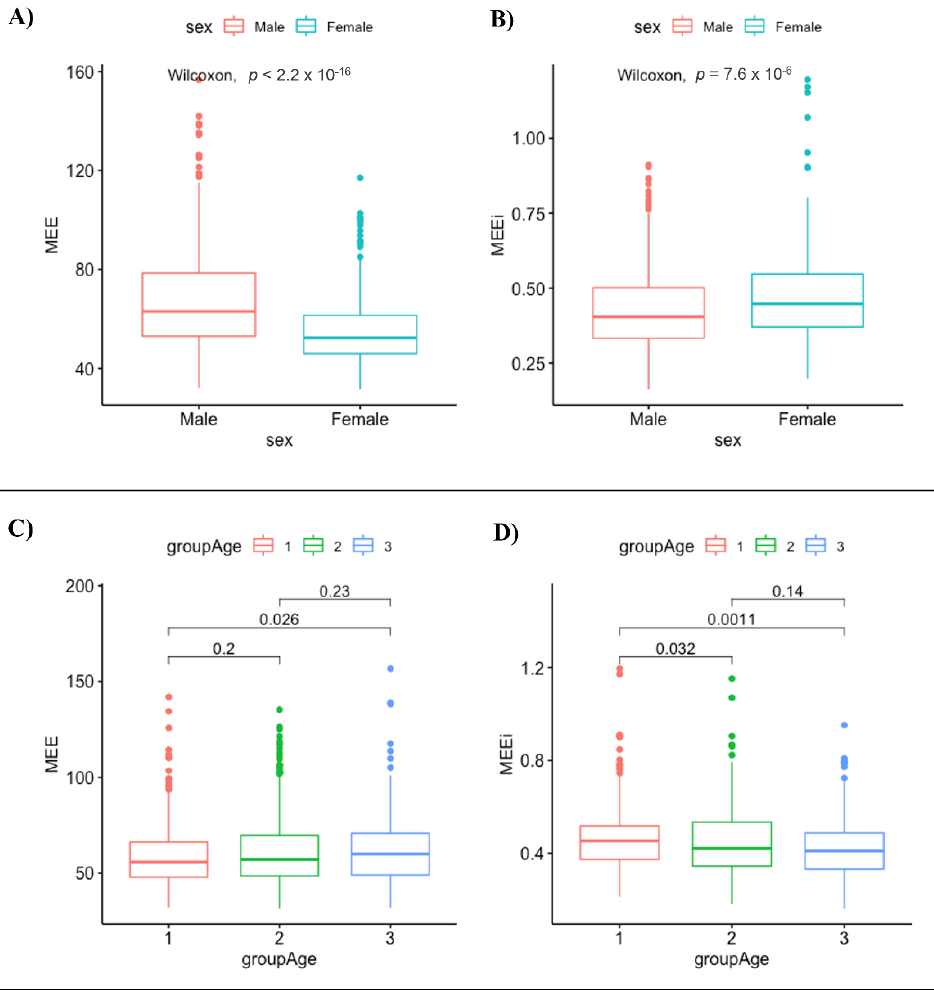
Figure 1. Normal ranges for MEE ( A ) and MEEi ( B ) by gender and normal ranges for MEE ( C ) and MEEi ( D ) by age.